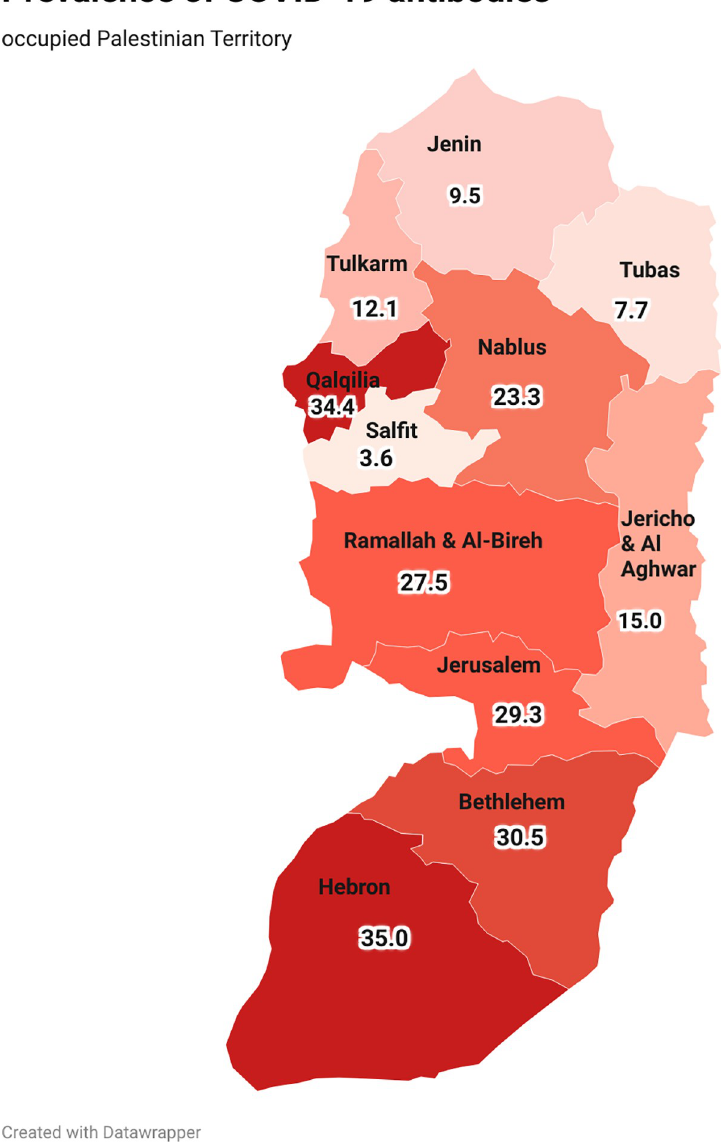
Fig 1. Serologically reported cases of severe acute respiratory syndrome coronavirus-2 (SARS-CoV-2) in the general population of Palestine between November 1, 2020 and December 30, 2020. “Reprinted from [27] under a CC BY license, with permission from [datawrapper], original copyright